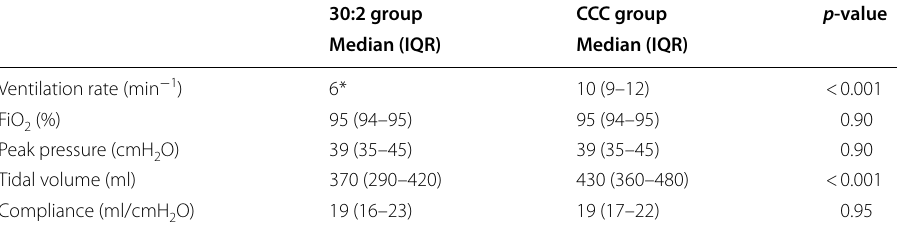
CCC: continuous chest compressions; FiO 2 : fraction of inspired